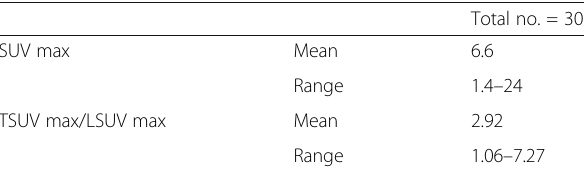
Table 3 Statistical data analysis of SUV max and TSUV max/ LSUV max